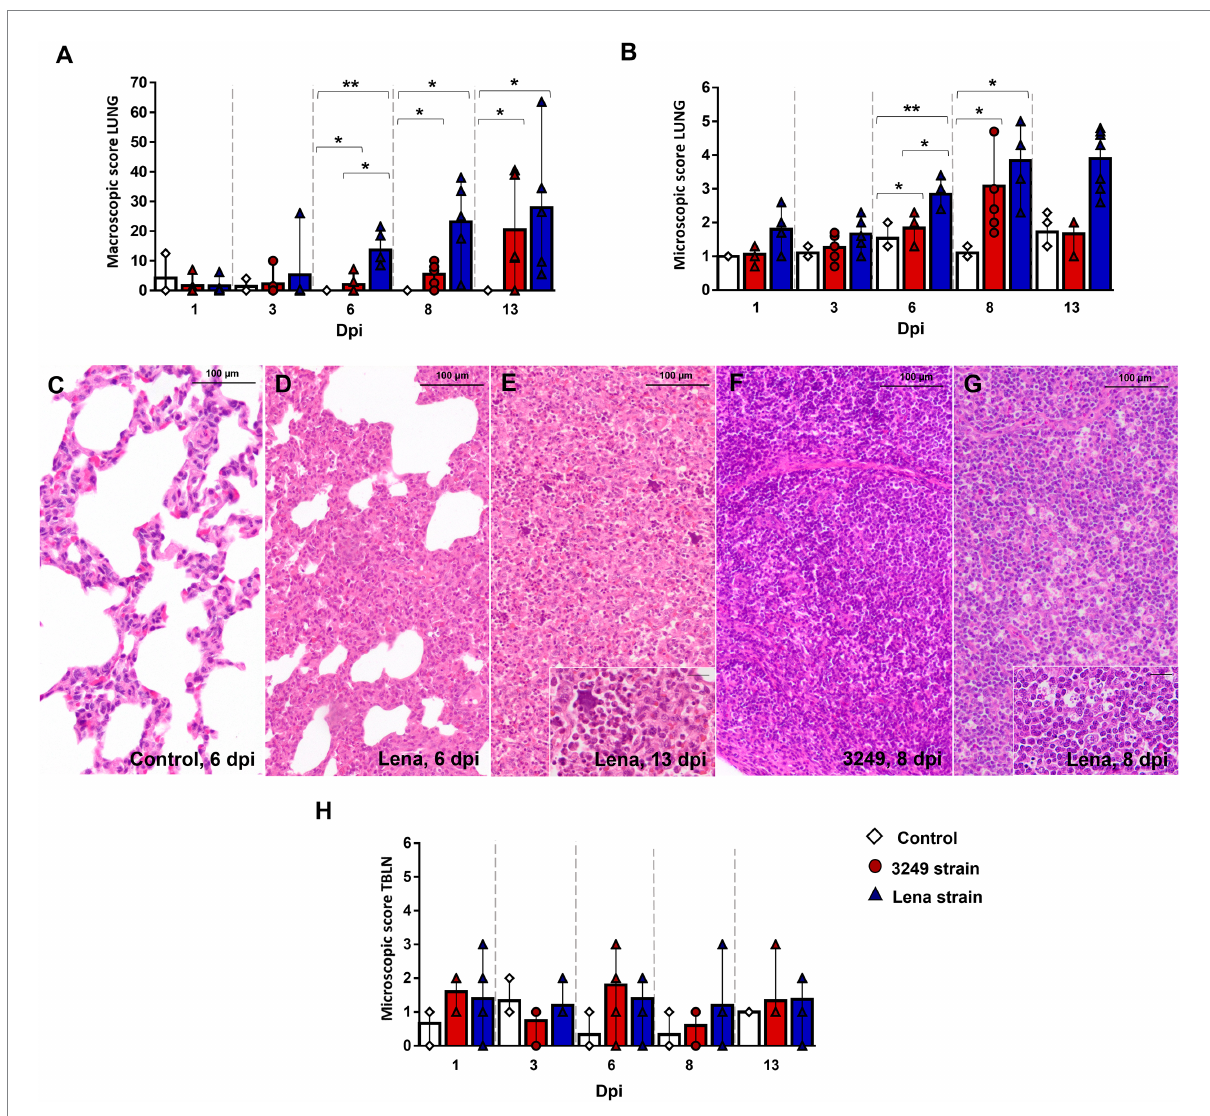
FIGURE 1 Gross and histological findings in lung and tracheobronchial lymph node. Graphs represents macroscopic (A) and microscopic score in lung (B) from control (white diamonds), 3249- (red circles) and Lena- (blue triangles) infected groups. Lung from a control animal (C) and from Lena- infected animals euthanized at 6 dpi (D) and 13 dpi (E) , showing severe interstitial pneumonia and bronchopneumonia, respectively. Inset shows neutrophils and cell debris filling alveolar lumen (bar 20 μ m). Tracheobronchial lymph node from 3249- (F) and Lena- (G) infected animals euthanized at 8 dpi. Inset shows numerous tingible body macrophages (bar 20 μ m). Graphs represents microscopic score in tracheobronchial lymph node (TBLN) (H) . Columns represent the median with interquartile range (IQR). Significant differences between groups in lung are represented (* p ≤ 0.05 and ** p ≤ 0.01). Dpi, days